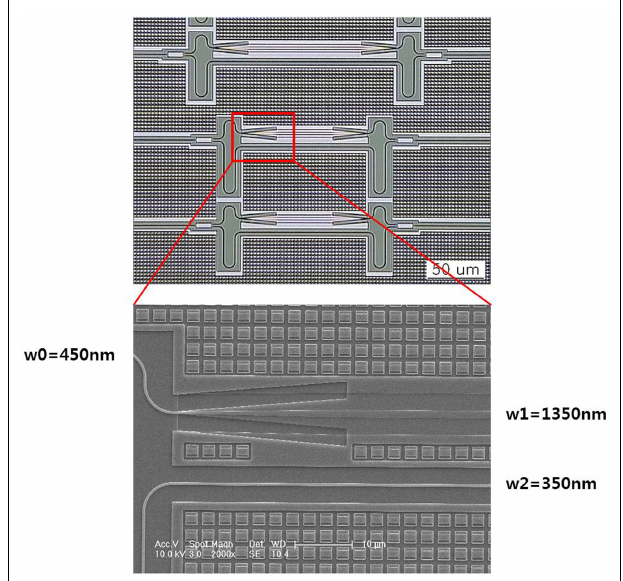
FIGURE 2 | A microscope image and a SEM image of silicon MZIs fabricated in this experiment .